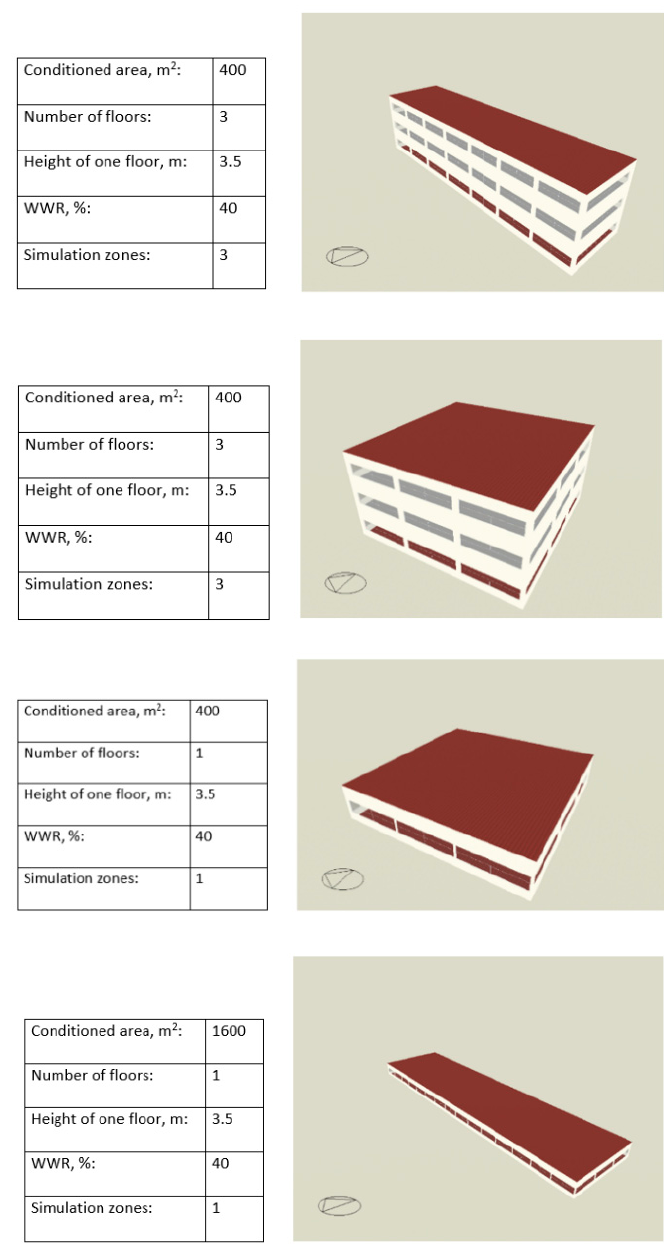
Figure 6. Simulation base cases.